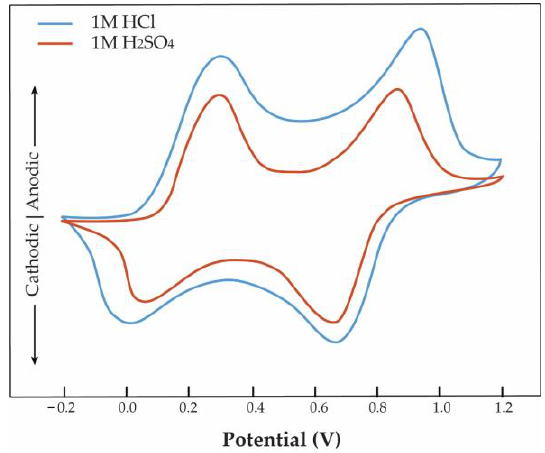
Figure 7. Cyclic voltammetry (CV) curves of a polyaniline (PANI) film doped with hydrochloric acid or sulfuric acid at the same potential scan rate 50 mV·s −1 .